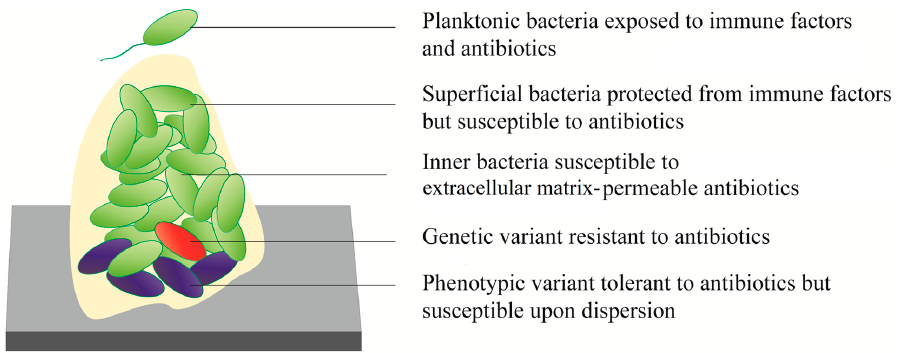
Figure 3. The heterogeneous susceptibility of bacterial biofilms to antibiotics [88] .